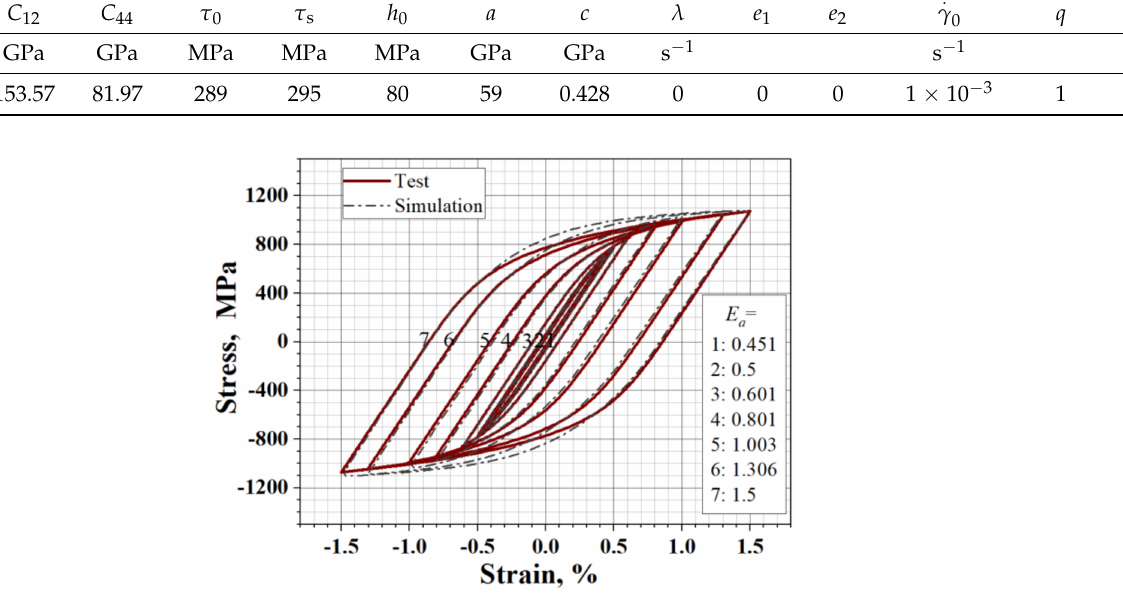
Table 1. Elastic constants and crystal plasticity parameters of the GH4169 superalloy at 500 ◦ C. Elastic Constants